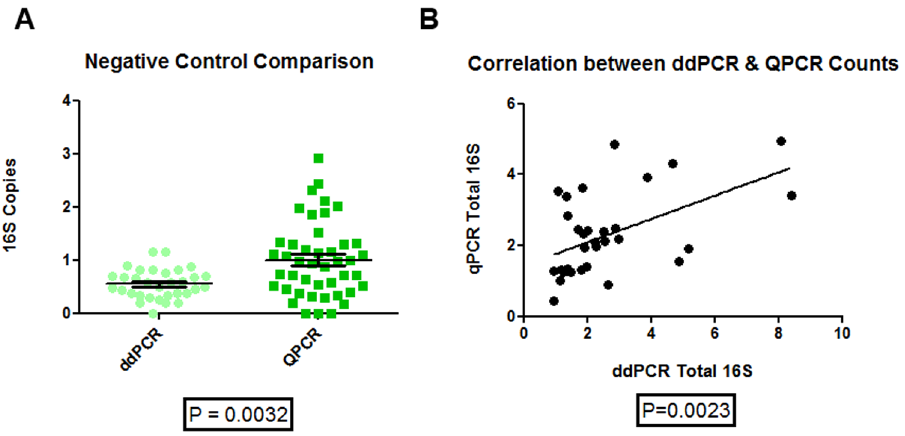
Figure 2. Negative control and direct 16S ddPCR versus qPCR comparisons. A) Direct comparison of the negative control for total bacterial 16S count between ddPCR and qPCR. There was a significant difference between the ddPCR and qPCR negative controls with ddPCR being on average lower. B) The linear correlation between the qPCR and ddPCR results were significant (y = 0.33 6 + 1.44, R 2 of 0.27).